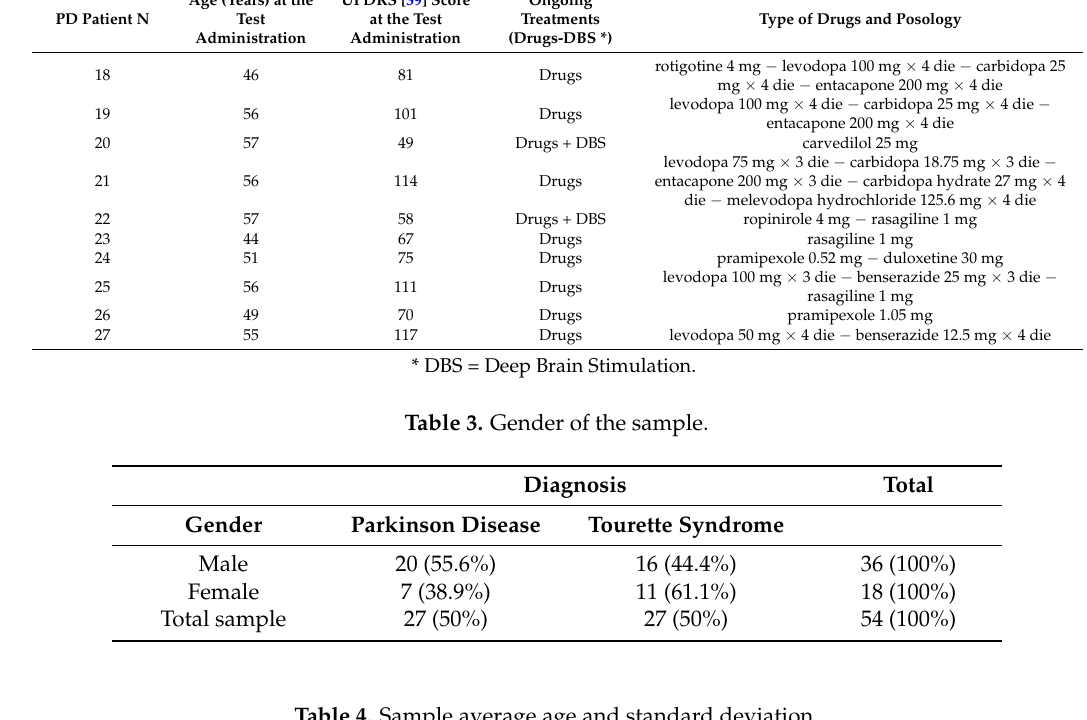
Table 4. Sample average age and standard deviation.